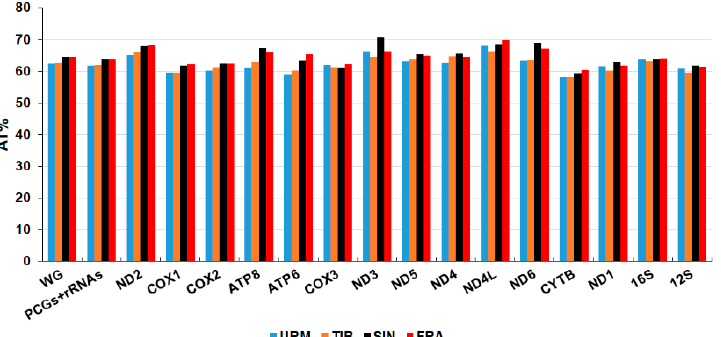
Figure 8. AT content (%) of the complete mitochondrial genome, protein-coding and ribosomal RNA genes in the mitochondrial genome of A. urmiana and three related species in genus Artemia (URM: A. urmiana , TIB: A. tibetiana , SIN: A. sinica , FRA: A. franciscana ). Diversity 2021 , 12 , x FOR PEER REVIEW 13 of 18 Detailed information of AT- and GC-skews in each individual protein-condoning gene and the ribosomal ones are provided in Table S3 and Figure 2. It was determined that AT- and GC-skews were positive for both ribosomal RNA genes. Generally, nucleotide skewness was positive with some exceptions. With the exception of FRA, the GC-skews of ND5 were positive for all species, with TIB (0.087) presenting the highest value. In COX1 and ND5, the GC-skew of FRA was reported zero with equal content of G and C. There were two obvious heterogeneity in the value of GC-skew in COX3 and ND1, where TIB (0.013)/FRA (0.096) and URM (0.035)/SIN (0.003) exhibited positive skewness, respectively. The distributional pattern of Artemia species based on AT- and GC-skew values of CmtG and PCG+rRNA sequences were shown on scatter plots (Figure 9). The results have documented the apparent dissimilarity of A. franciscana from other taxa.